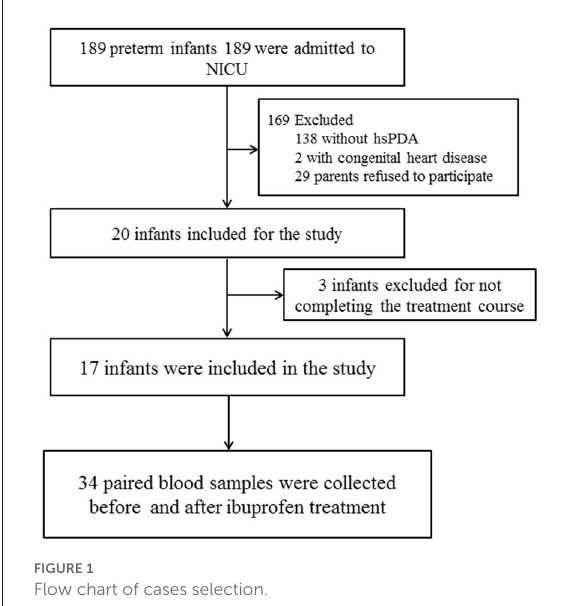
FIGURE1 Flow chart of cases